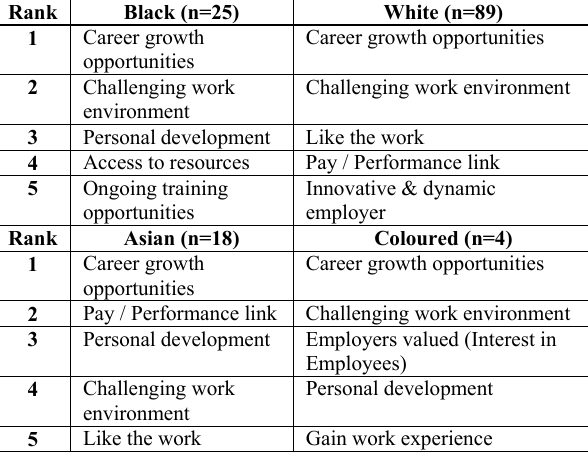
Table 8: The top five attributes for the four categories